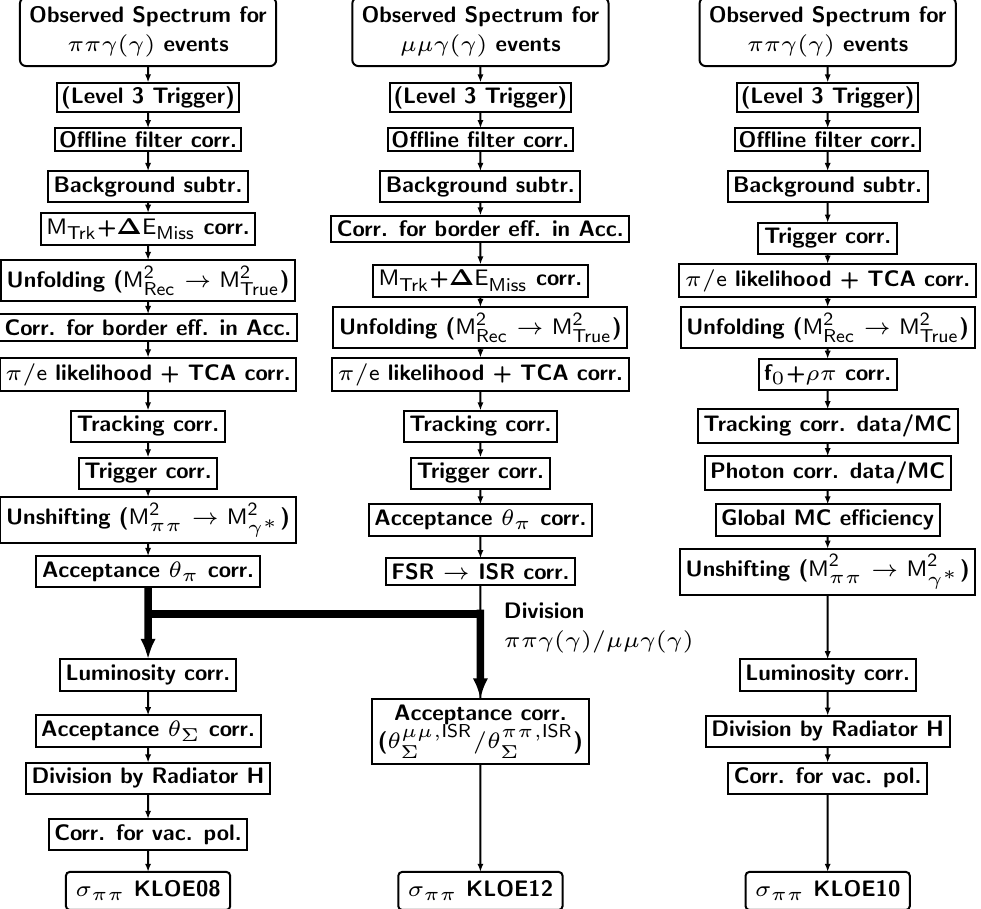
(cid:0) (cid:1) e + e (cid:0) ! (cid:25) + (cid:25) (cid:0) (cid:13) ( (cid:13) ) cross sec-